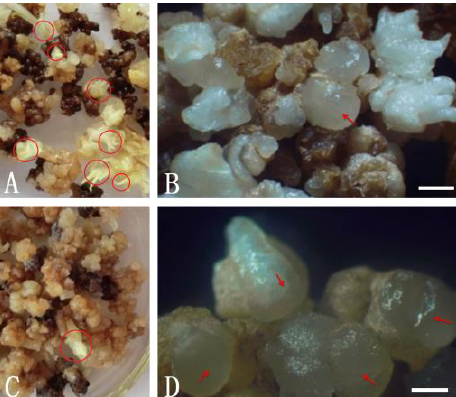
Figure 5. Effect of methylation inhibitor 5-azaC treatment on somatic embryo induction. ( A , B ) Display embryos without 5-azaC pretreatment, and ( C , D ) display embryos with 5-azaC pretreatment, and all panels are representative images of embryos 30 days after somatic embryo induction. Arrows indicate globular embryos. Circles indicate adventitious shoots. Scale bar = 400 μm.